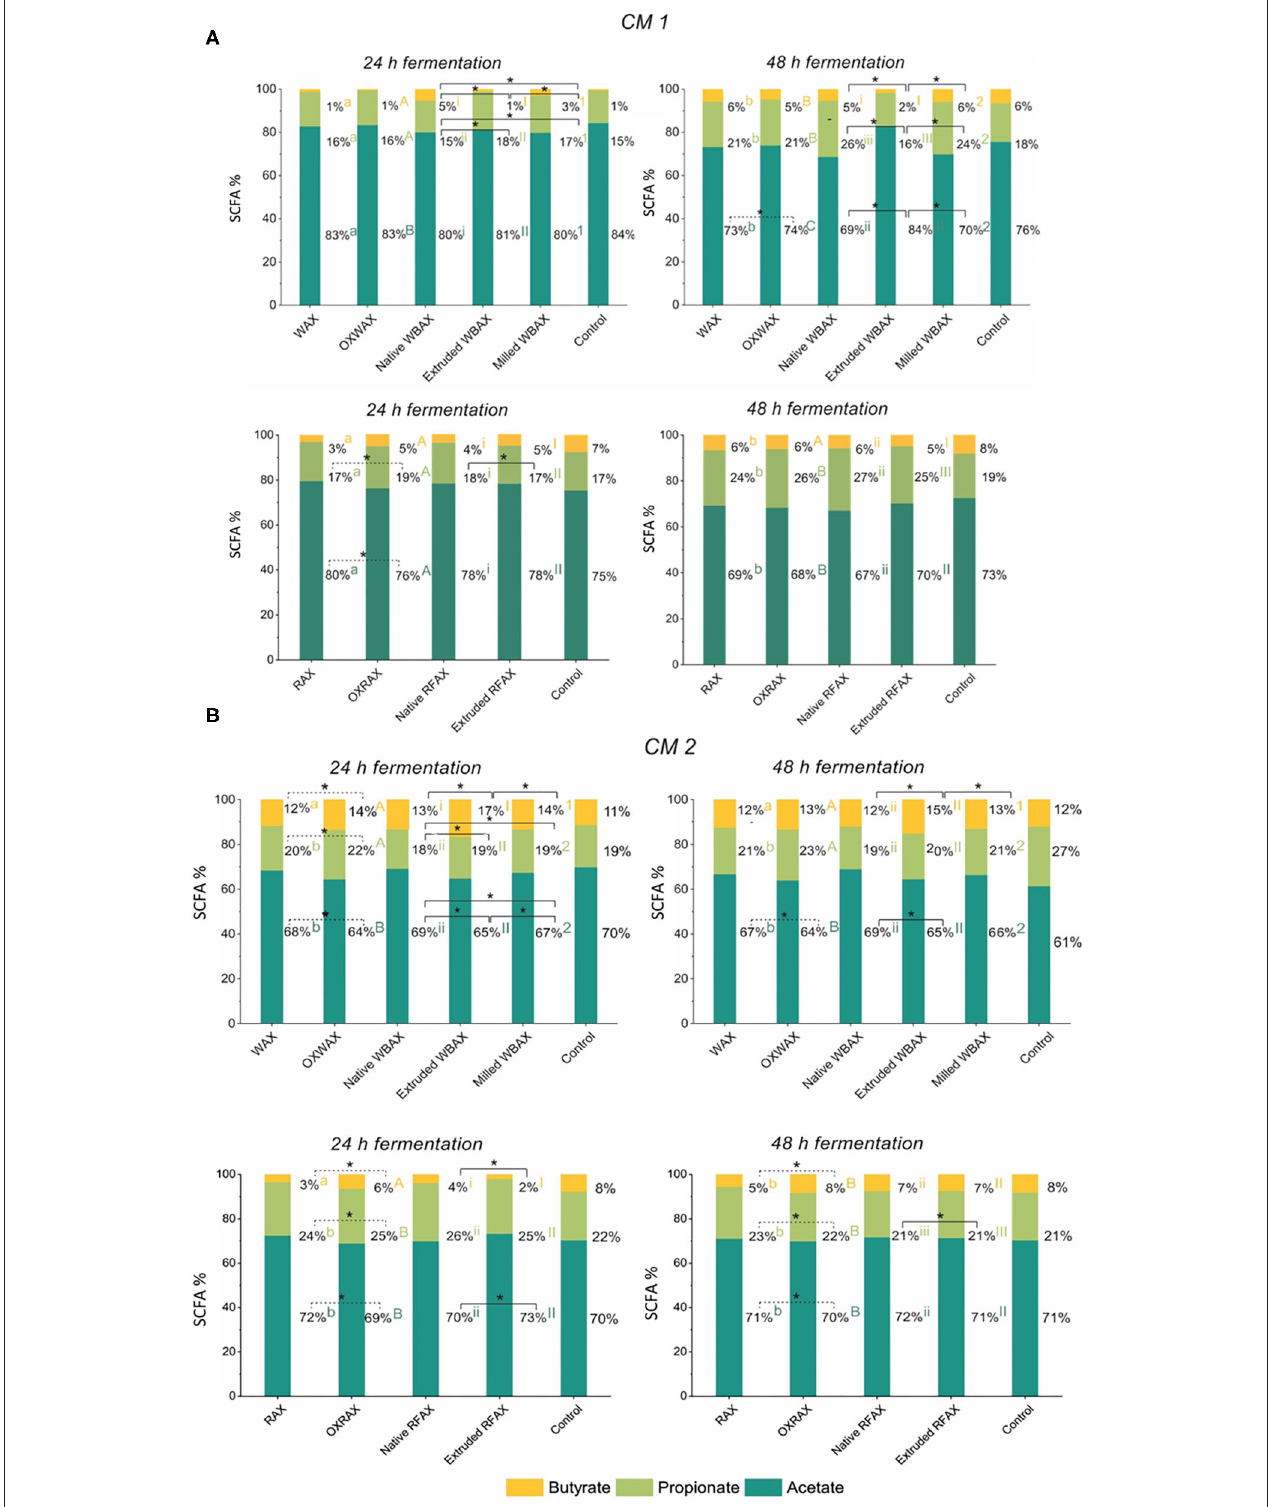
FIGURE 3 | Relative abundance of the end metabolites acetate, butyrate, and propionate after 24 and 48h in vitro fermentation of differently processed WBAX and RFAX by CM 1 (A) and CM 2 (B) . Different letters indicate the significant differences between average profile at 24 and 48h for the different AX treatments. Lines indicate significant differences between the differently processed AX samples at 24 or 48h. All significant differences correspond to α = 0.05(*).